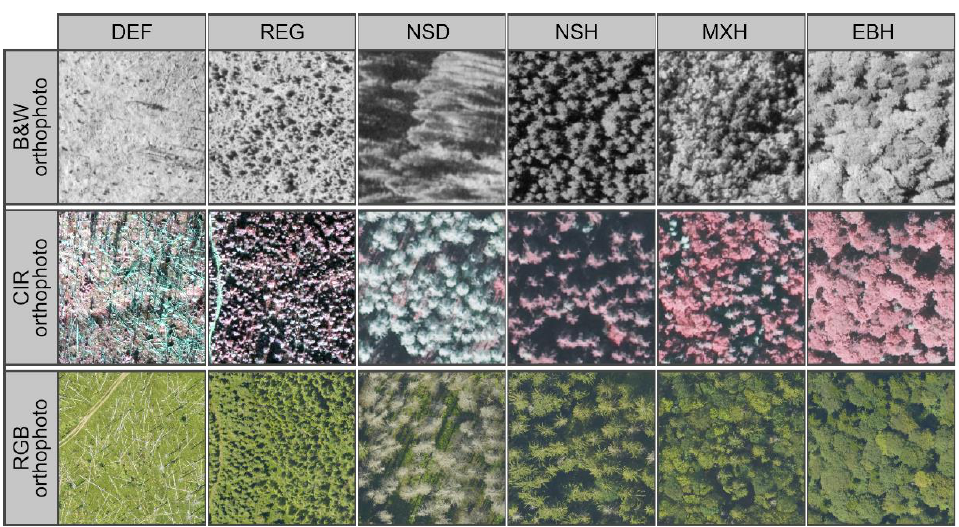
Figure 2. A photointerpretation key developed for defined LC classes for three types of color composite orthophoto imagery used in the study. LC class abbreviations: DEF: deforested areas with fallen deadwood, forest gaps; REG: young forests on post-decline areas; NSD: standing, dead and severely damaged groups of Norway spruce trees; NSH: mature, healthy forest stands dominated by the Norway spruce; MXH mature, healthy mixed forest stands; EBH: healthy, forest stands dominated by the European